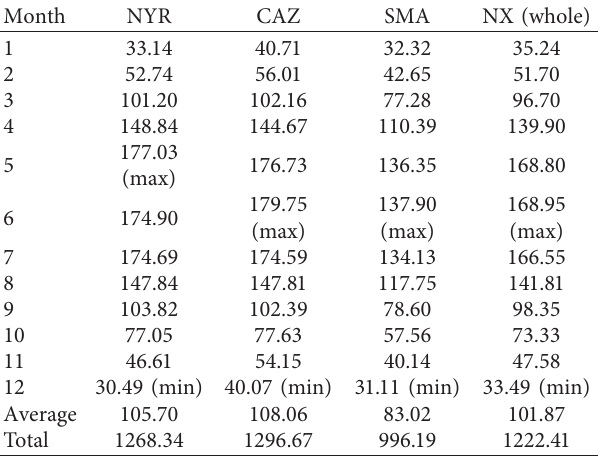
Figure 5: Mann–Kendall test of each region at annual scale: (a) NX; (b) NYR; (c) CAZ; (d) SMA. Table 3: Monthly average of ET 0 in Ningxia and each